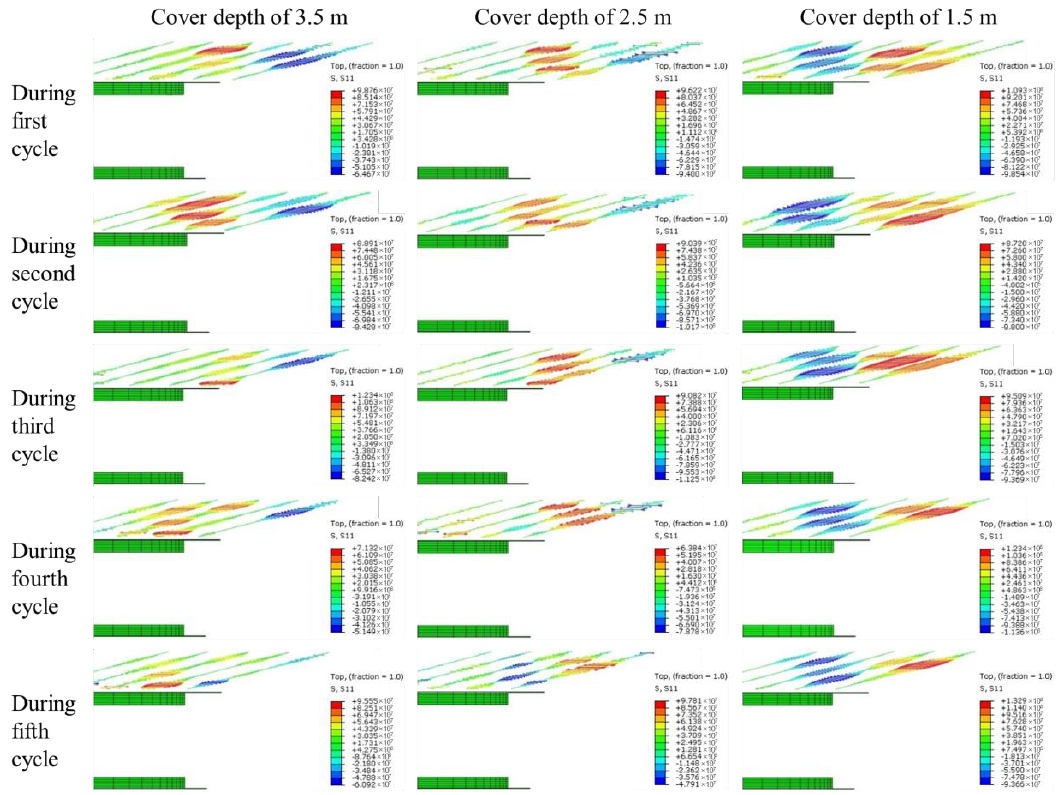
Figure 24. Stresses acting on piles during Stage 2 of each construction cycle.